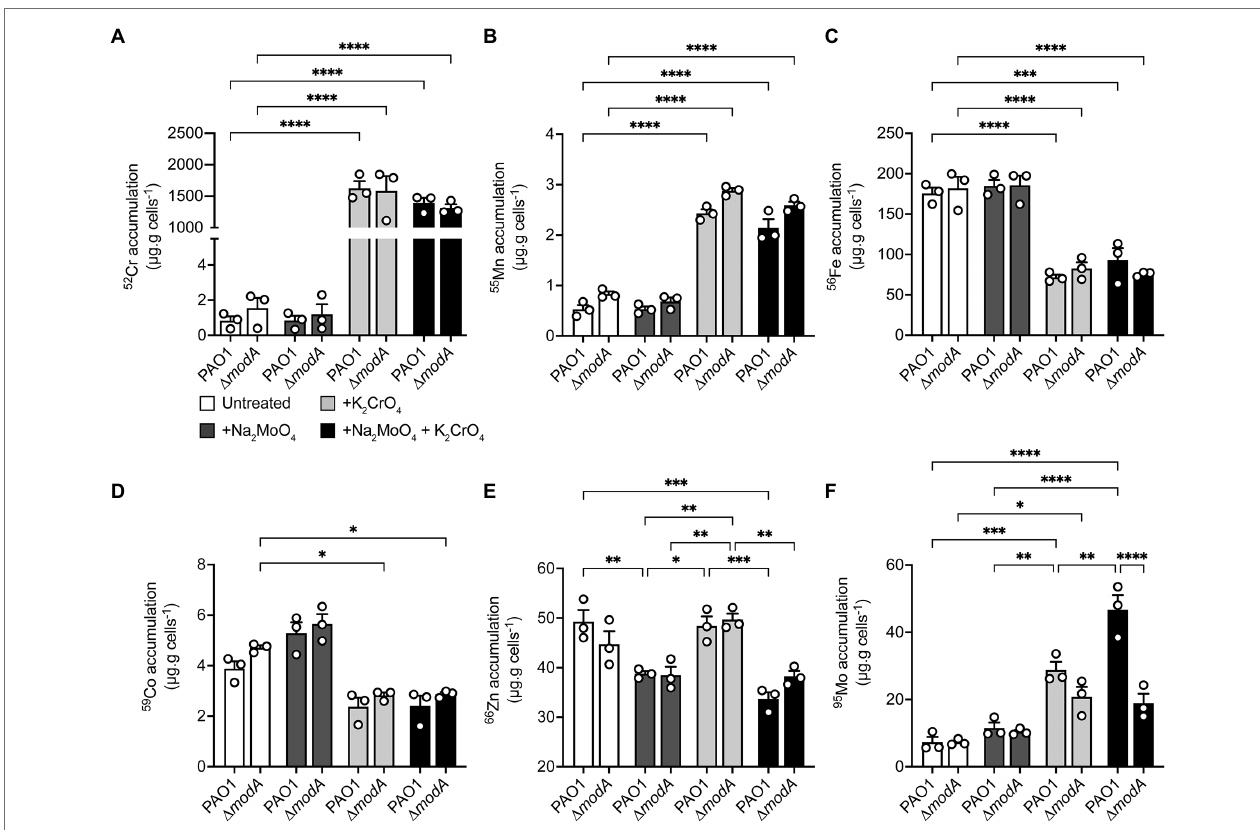
FIGURE 6 | Modulations in cellular metal ion content under aerobic conditions in response to chromate and molybdate exposure. Whole cell accumulation of (A) chromium, (B) manganese, (C) iron, (D) , cobalt, (E) zinc, and (F) molybdenum in P. aeruginosa PAO1 wild-type and ∆ modA strains grown aerobically in untreated M-CDM media or media supplemented with 320 μ M Na 2 MoO 4 and/or K 2 CrO 4 . Data represents the mean (±SEM) of three independent experiments. Statistical significance of the differences was determined by two-way ANOVA with Sidak post-test, * = p < 0.05, ** = p < 0.01, *** = p < 0.001, and **** = p <